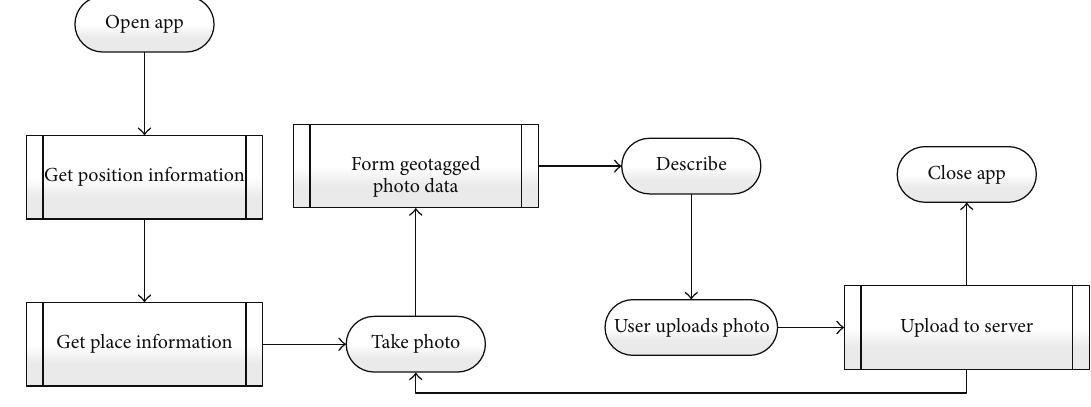
Figure 3: Collection process and data form.